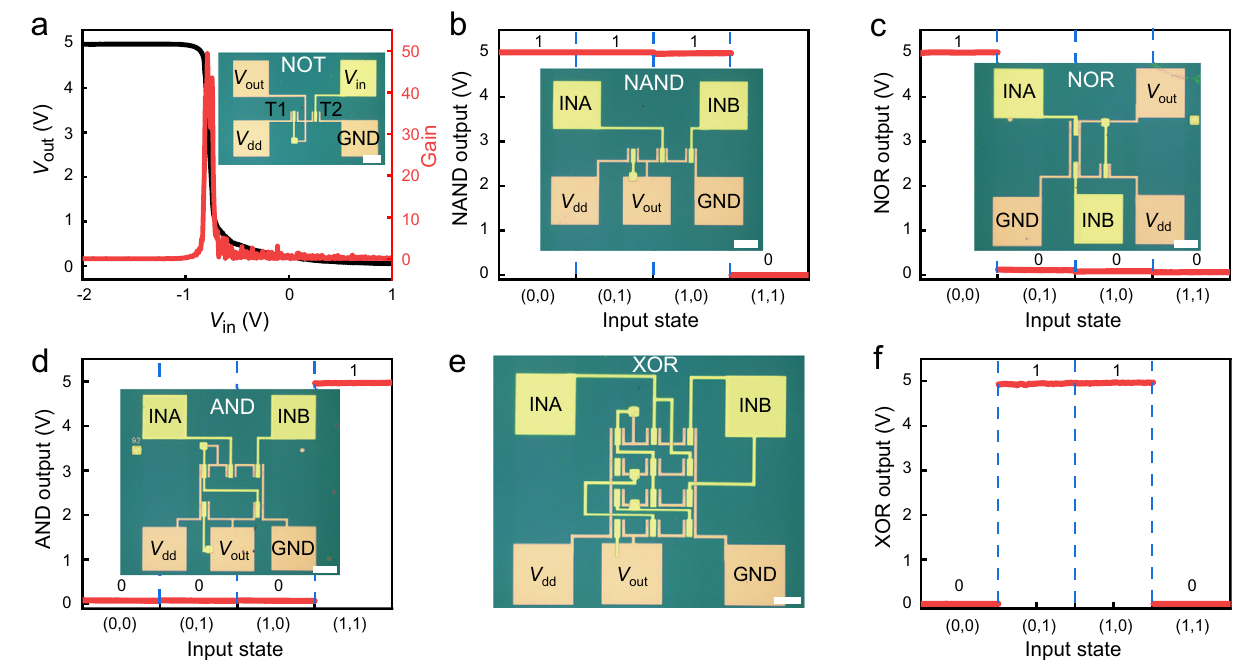
Fig. 4 | Large-scale logic circuit made by vdWs dielectric integration method. a The output voltage (black line and left axis) versus input voltage V in and voltage gain (red line and right axis) as a function of V in of a NMOS inverter under V dd ~5V. The corresponding optical image is shown as inset. b – d Output voltage and cor- responding optical image (inset) of NAND gate ( b ), NOR gate ( c ) and AND gate ( d )